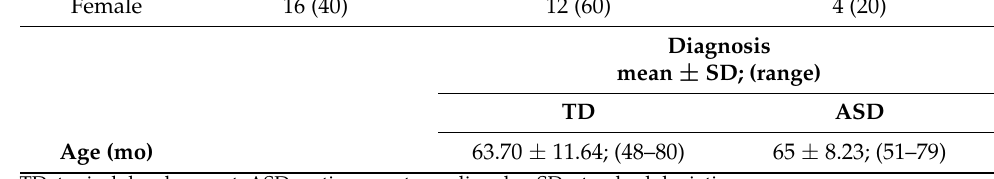
Diagnosis n (%) TD ASD Diagnosis mean ± SD;